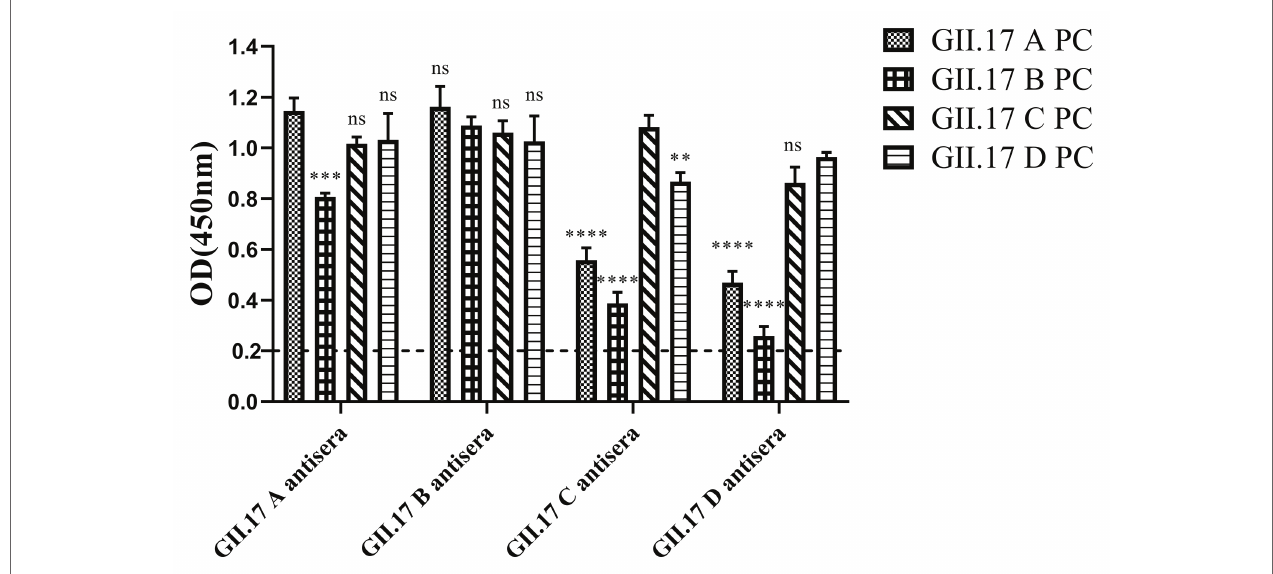
FIGURE 4 | GII.17 antibody responses in homologous and heterologous mouse immune antisera. Antisera of GII.17 A, GII.17 B, GII.17 C, and GII.17 D were analyzed for cross-reactive responses. OD values were expressed as the mean ± SD. Dotted line represents the cut-off value for samples was considered as positive. * Significantly different from homotypic sera (by ANOVA). * p < 0.05; ** p < 0.01; *** p < 0.001; and ∗∗∗∗ p < 0.0001. ns, not significant.